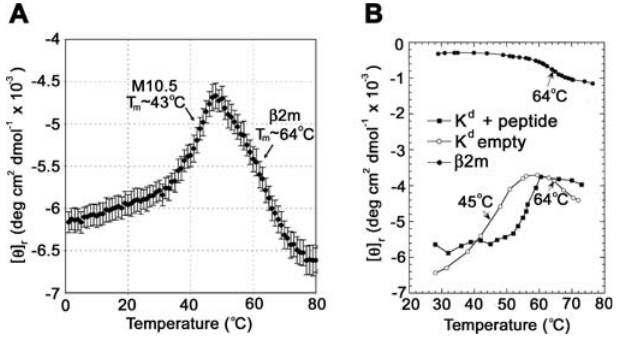
Figure 5. Thermal Denaturation Profiles Thermal denaturation of M10.5 (A) compared with empty and peptide- filled H-2K d (B) (modified from Figure 3A in Fahnestock et al. [21]). The CD signal at 223 nm was monitored as a function of temperature for insect cell-derived M10.5 and empty and peptide-filled versions of soluble H-2K d produced in CHO cells. T m s for the melting of the M10.5 heavy chain and b 2m light chain (marked with arrows) were derived by estimating the half-point of the ellipticity change between the beginning and end of each transition. The M10.5 denaturation profile is similar to the profile obtained from empty H-2K d , suggesting that the M10.5 groove is not occupied. The possibility that polyethylene glycol, a component in the crystallization solutions, might bind to and stabilize M10.5 was investigated by repeating the unfolding experiment in the presence of 20% polyethylene glycol 1000, with no significant changes to the thermal stability profile (data not shown). DOI: 10.1371/journal.pbio.0030257.g005